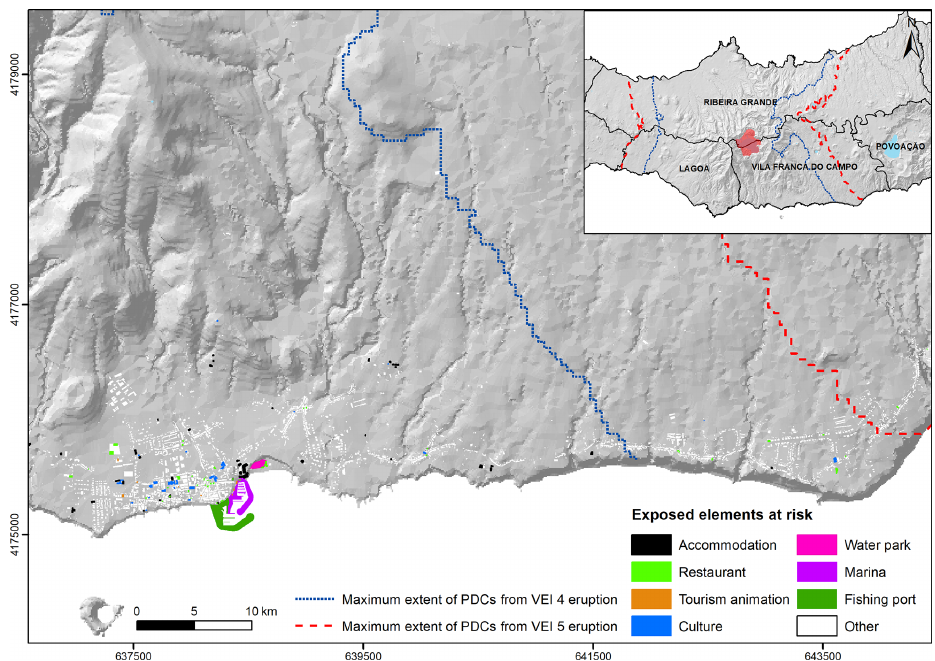
Figure 9. Spatial distribution of the elements at risk in Vila Franca do Campo municipality (colour polygons) affected by PDCs resulting from VEI 4 sub-Plinian (dotted blue line) and VEI 5 Plinian (dashed red line) eruptions of Fogo volcano. UTM coordinates, zone 26S, datum WGS 84.